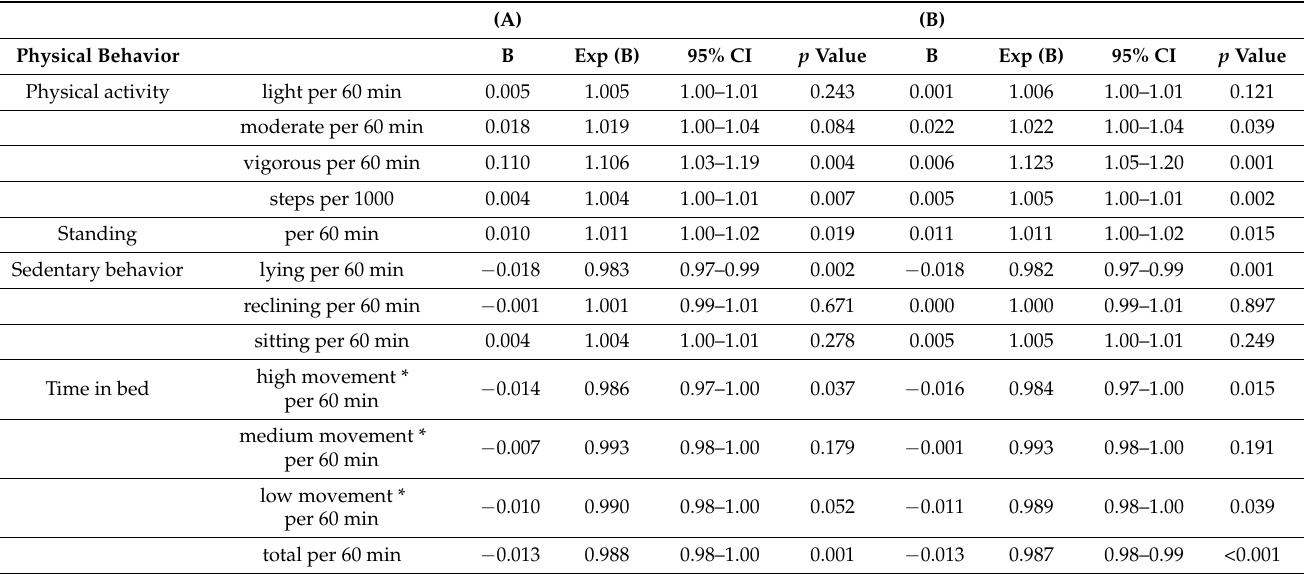
Table 4. Gamma regression on the association between physical behavior and work ability (sWAI) adjusted for age group, sex, education, physical work demands, and cardiorespiratory fitness